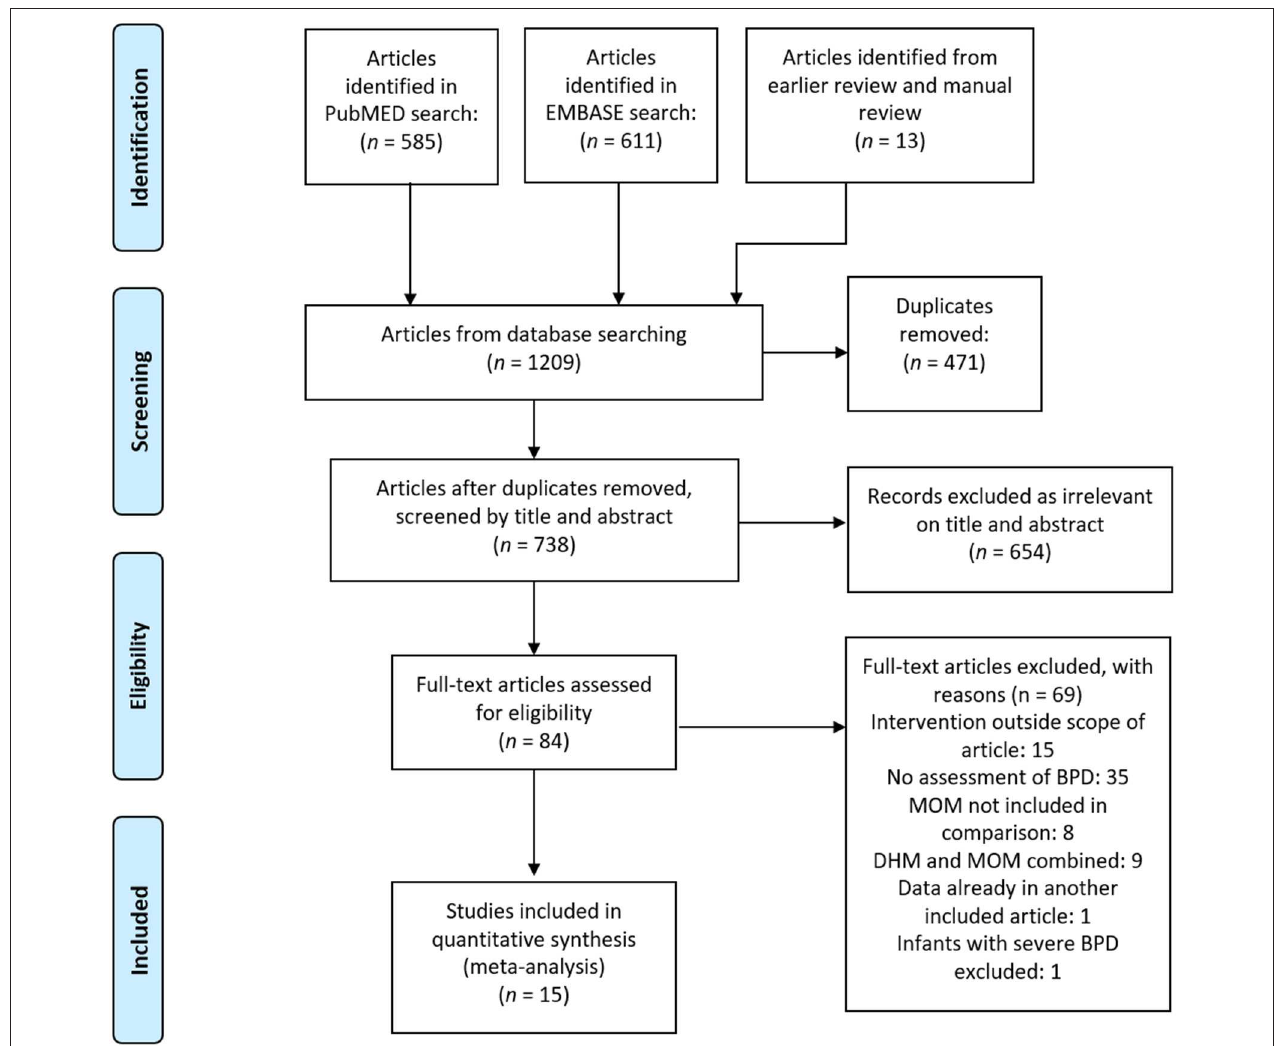
FIGURE 1 | PRISMA diagram of the